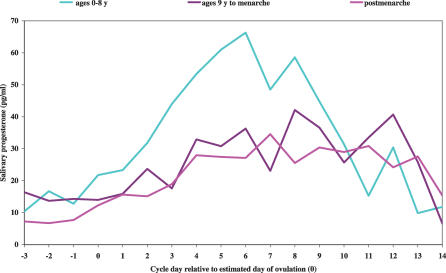
Average Luteal Progesterone Profiles by Categories of Age at Migration to the UKUnadjusted mean luteal progesterone index values. Mean ± SEM: 44.3 ± 8.6 pg/ml (ages 0–8 y, n = 22); 31.8 ± 6.8 pg/ml (ages 9 y to menarche, n = 17); 24.6 ± 2.5 pg/ml (postmenarche, n = 46). Ovulation dates were estimated from oestradiol data available for the same individual menstrual cycles [22]. Confidence intervals are omitted for visual clarity. Sample sizes include all women for which hormonal data were available and may differ from total sample size for other aspects of data collection.